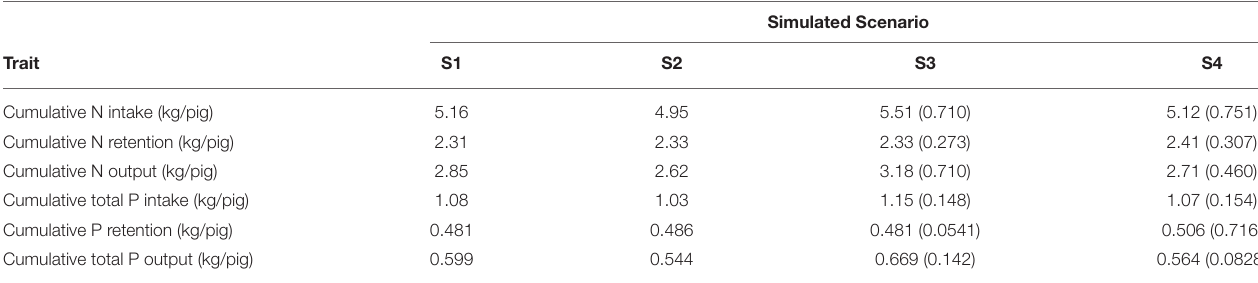
TABLE 4 | Calculated nitrogen ( N ) and phosphorus (P) balances in each of the four simulated scenarios in terms of mean values (S1 and S2 for the average pig) and mean (SD) values (S3 and S4 for the population of